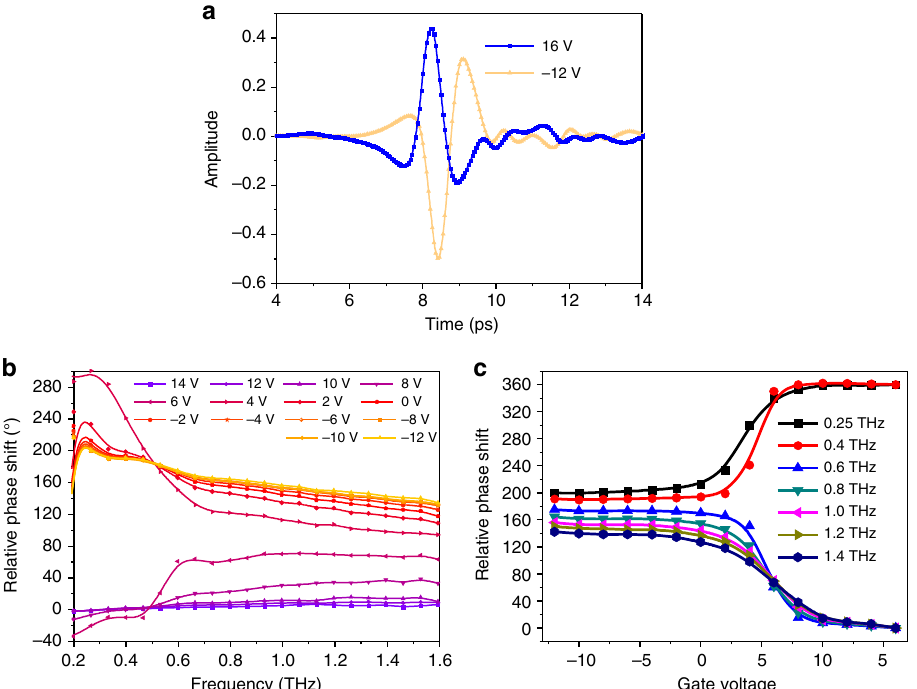
Fig. 5 The device worked as a THz-phase modulator under an incident angle of 68°. a Re fl ected THz time-domain signal at the gate voltages of 16 and − 12 V. b Relative phase shift referenced to the phase shift at 16 V from 0.2 to 1.6 THz. c Phase shift as a function of gate voltage at different